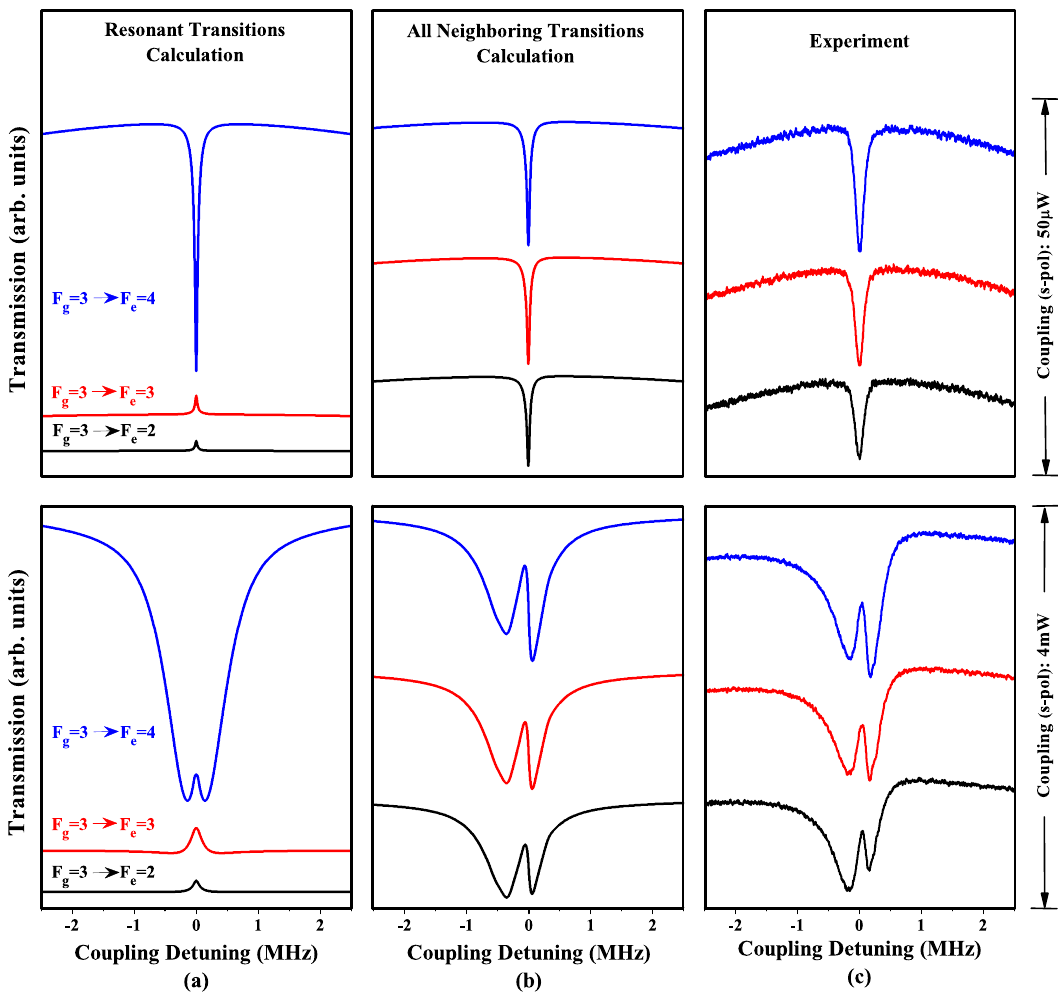
2 3 3 3 4 3 2 ′ , ′ and ′ ; ( b ) a transition resonant at ′ with neighboring hyperfine transitions of → → → → 3 3 3 3 4 ′ and ′ with neighboring transitions of ′ , a transition resonant at → → 4 3 2 3 resonant at 3 ′ with neighboring transitions of ′ and ′ ; ( c ) experimentally measured spectra for → → 2 3 3 3 4 resonant transitions 3 ′ , ′ , and ′ → → →